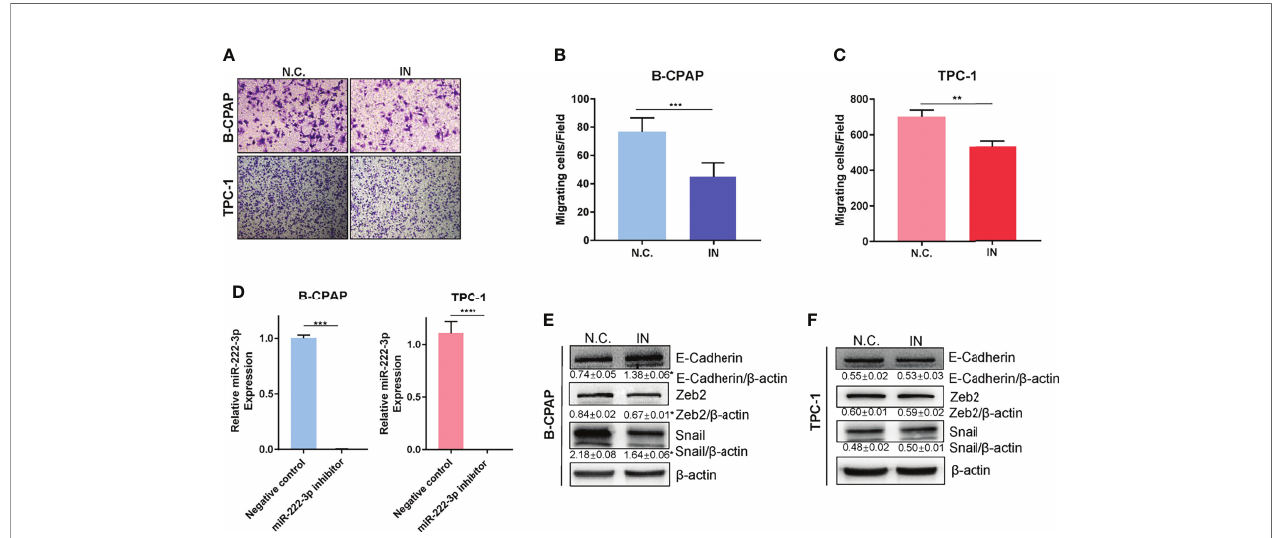
FIGURE 4 | Downregulation of miR-222-3p suppresses cell migration and EMT of PTCs. (A) Migration images of representative microscope fi elds (40x, 100x). (B, C) t -test analysis of the number of B-CPAP and TPC-1 migrating cells of N.C. and IN group. *** p< 0.001,**p < 0.01. (D) q-PCR validation of expression level of miR-222-3p in B- CPAP and TPC-1 transfected with negative control (N.C.) and miR-222-3p inhibitor (IN). ***p < 0.001,****p < 0.0001. (E, F) immunoblot of E-cadherin, Zeb2, and Snail protein from extracts of B-CPAP and TPC-1 transfected N.C. and IN. *p < 0.05.